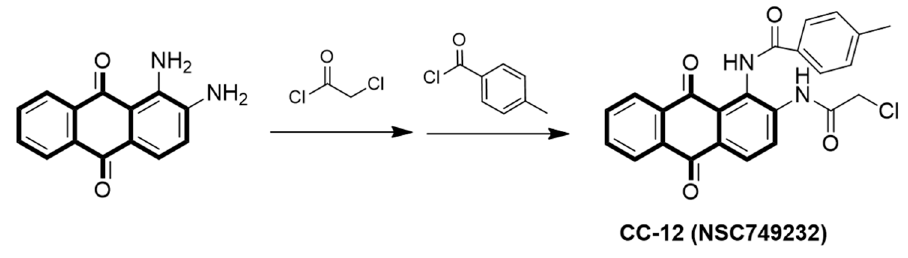
Figure 1. Chemical structures of CC12.